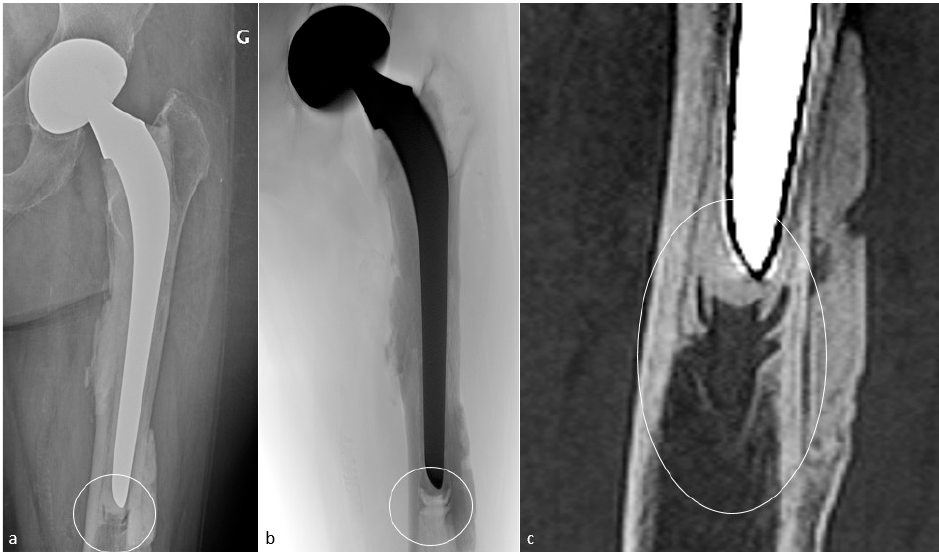
Figure 3. Distal centralizer in a cemented femoral stem. A centralizer is shown on an anteroposte ‐ rior radiograph ( a ), a tomosynthesis ( b ), and a CT ‐ scan reformat ( c ) (white circle). Note its radiolu ‐ cent and hypodense aspect. and hypodense